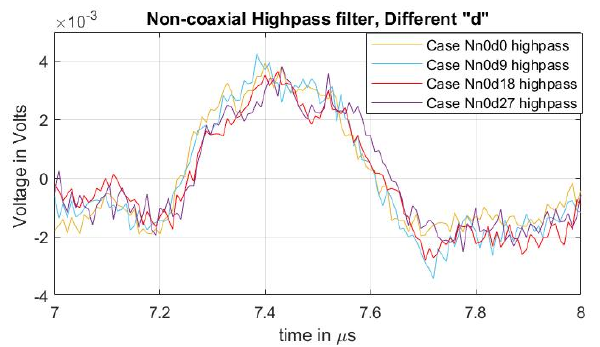
Figure 7. Acoustic magnitude comparison between cases of varying distance “ d ” for non-coaxial injection.